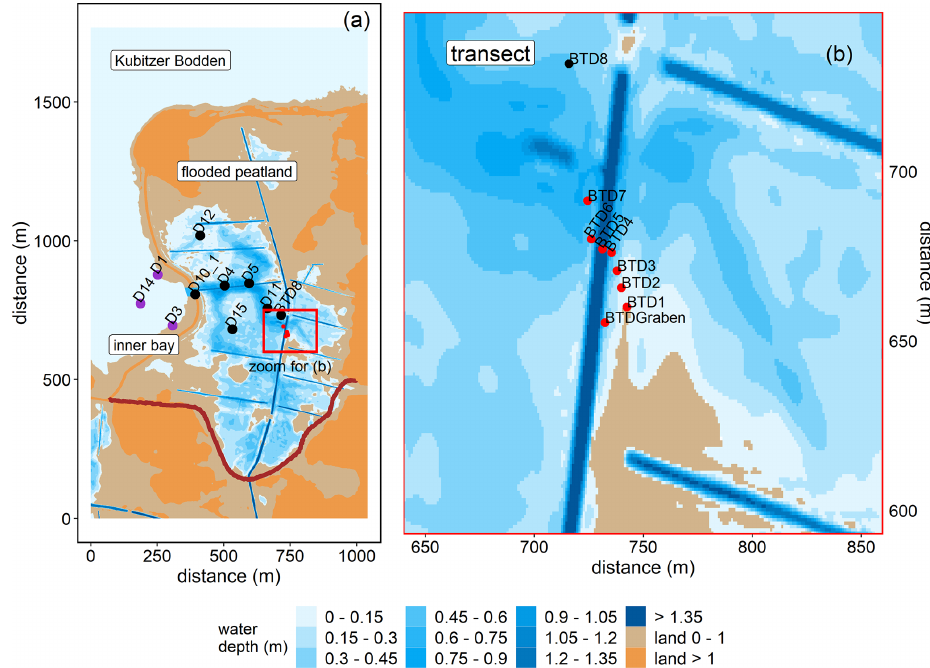
Figure 2. Topography of the study area and overview of the stations in the inner bay (purple), the flooded peatland (black), and along the transect of the GHG flux measurements (red). (a) Water coverage is shown at mean sea level. The new dike is shown in dark red. (b) Transect stations that were sampled for atmospheric chamber-based GHG flux measurements (before and after rewetting) and for surface water GHG concentration measurements (after rewetting). Data from station BTD7 were used for a comparison of the chamber-based measurements with the calculated air–sea fluxes after rewetting. Topography data retrieved from the Landesamt für innere Verwaltung MV, Amt für Geoinformation, Vermessungs- und Katasterwesen, Fachbereich